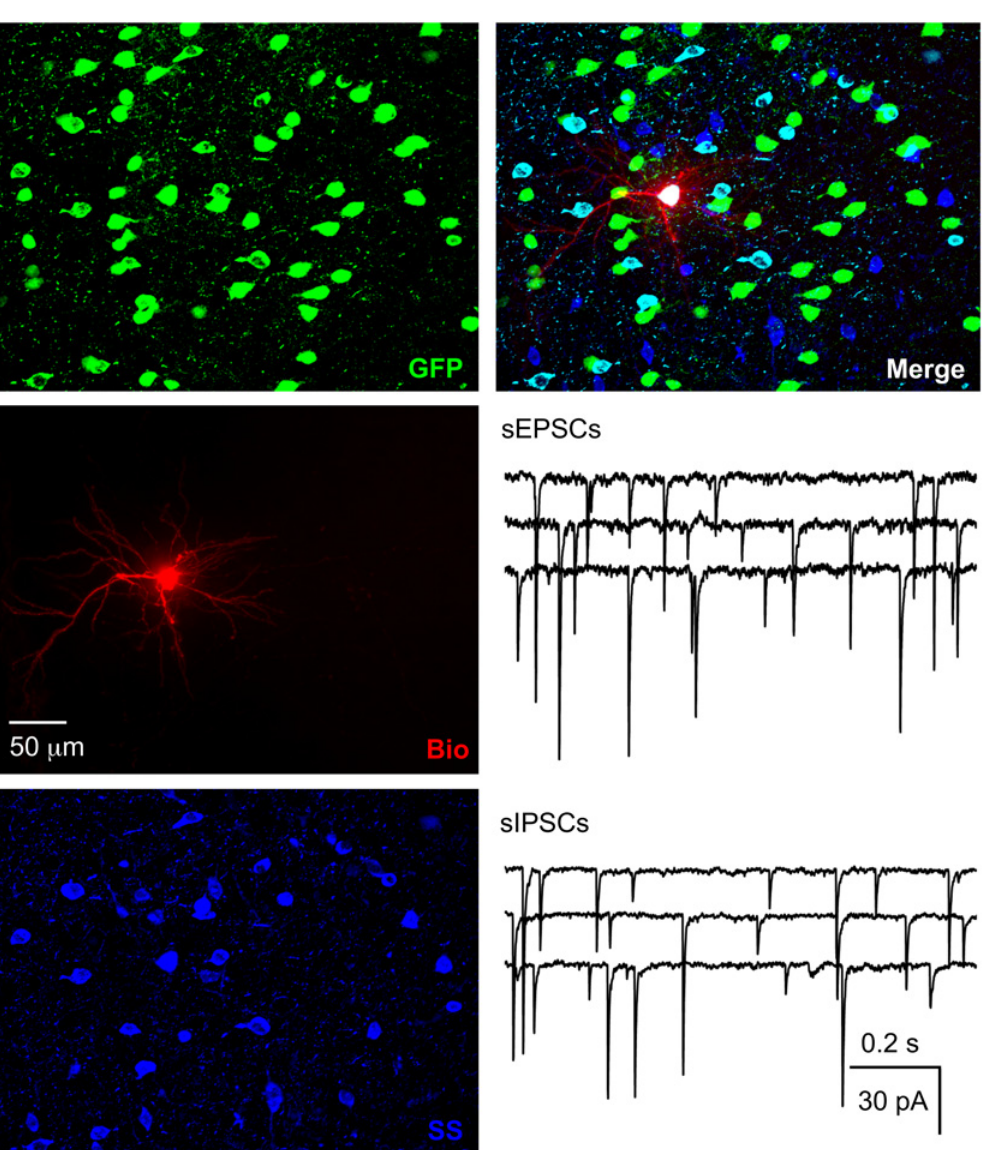
Fig 4. Functional integration of SS-ir hNPCs. The section with the recorded hNPC was further processed with anti-SS and the recorded hNPC was a SS-ir interneuron. Spontaneous IPSCs and EPSCs were recorded in SS-ir hNPCs. Traces for sIPSCs and sEPSCs were recorded from two SS-ir